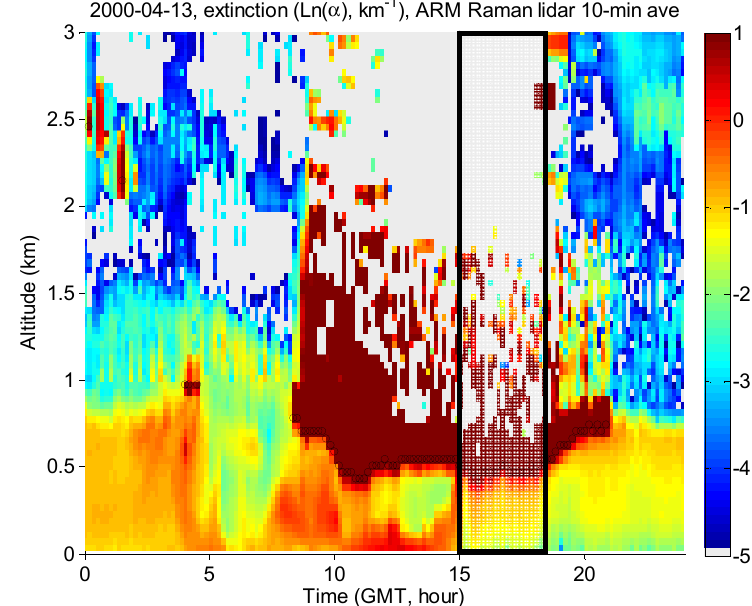
Figure 10. Raman Lidar derived extinction profile and marked cloud boundary for 13 April 2000 at ARM SGP